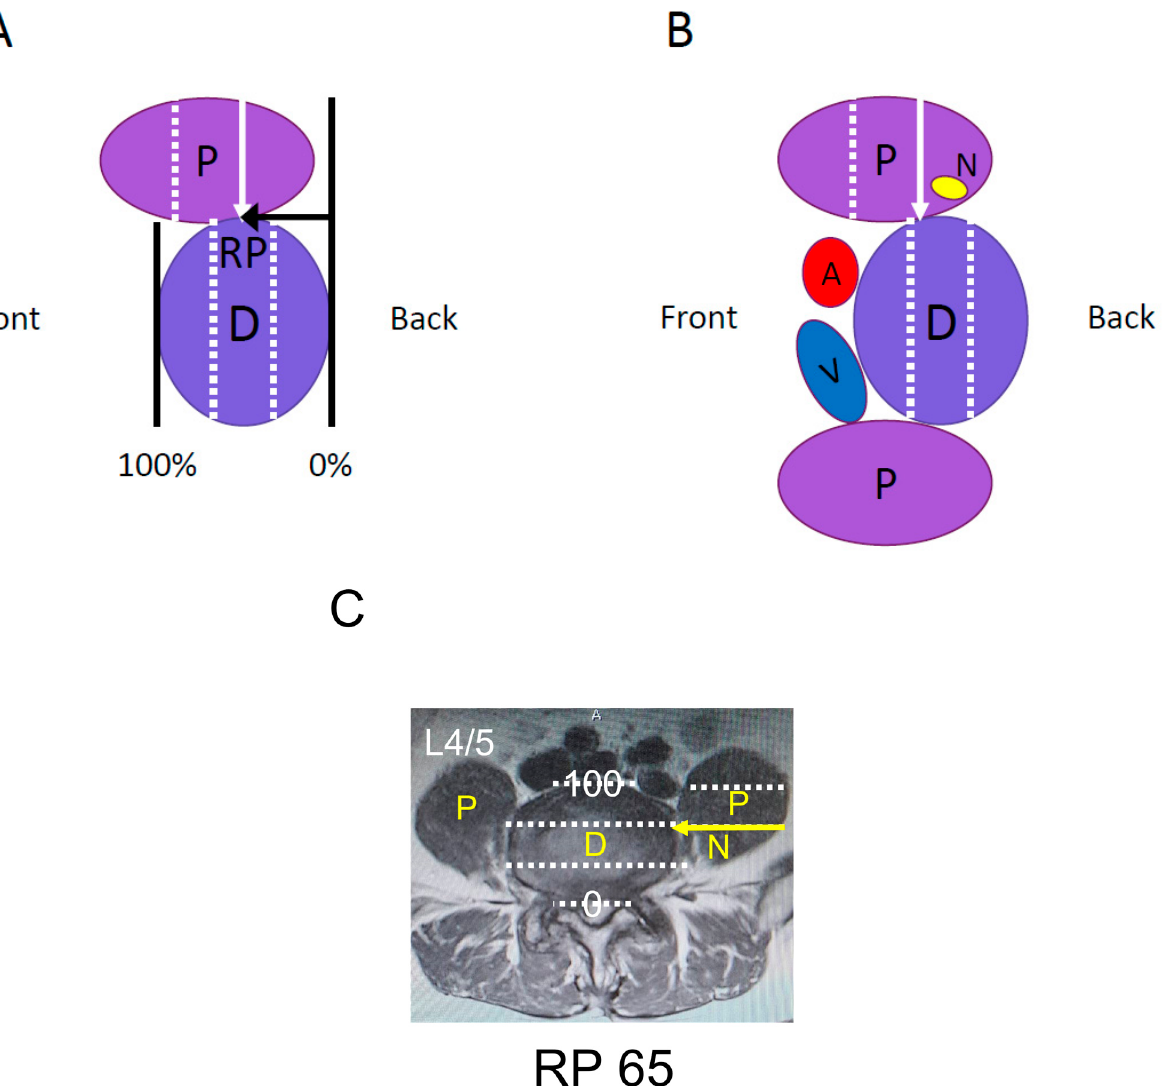
Figure 1. ( A ) Schema, showing the technique for measuring the relative position (RP) value on an axial view of a T2-weighted magnetic resonance image. The RP value was based on the position of the posterior third of the psoas muscle relative to the intervertebral disc in the anterior-posterior plane, with 0% and 100%, indicating the posterior and anterior edges of the intervertebral disc, respectively. ( B ) A RP value of ≤ 66.7% was considered an indication for lateral approach-interbody fusion. ( C ) This patient is indicated for transpsoas lateral approach with a RP value of 65 on MRI evaluation. White dotted lines indicate the trisecting lines of the intervertebral disc and psoas muscle. Yellow arrow indicates the posterior 1/3 line of the psoas muscle. P: psoas muscle, D: intervertebral disc, A: aorta, V: vein, N: